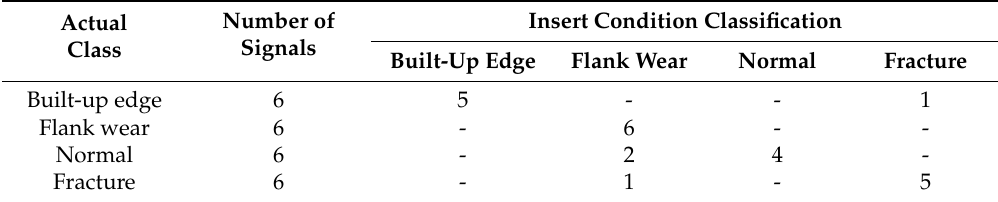
Table 8. Insert condition classification results. (cutting speed 290 m / min, depth of cut 1.9 mm, cutting feed 0.23 mm / rev).